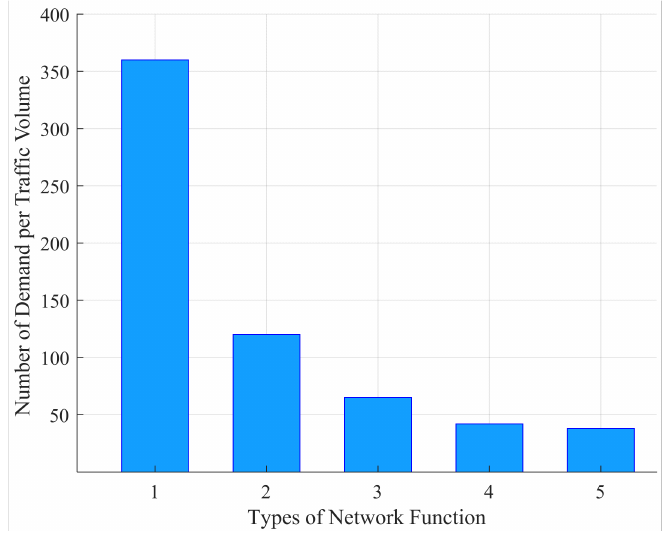
Figure 2. Content Popularity for Network Functions